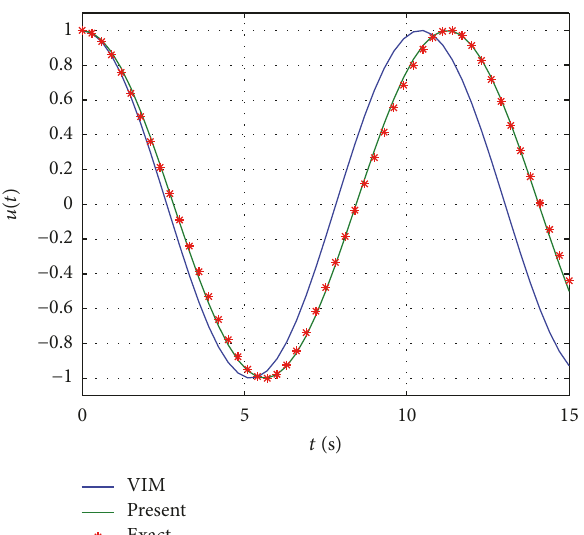
Figure 8: Comparison of time history diagram of displacement between the present, VIM, and exact solutions at 𝜂 = 0.9, 𝐴 = 1 , Example 3.